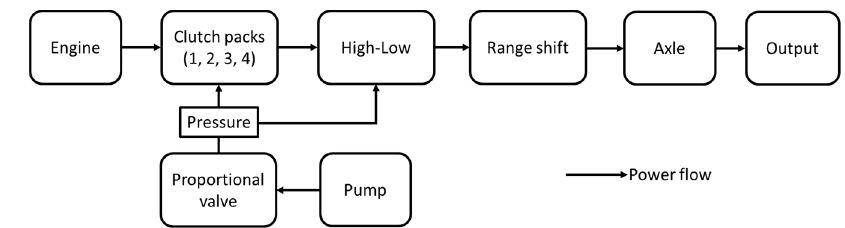
Figure 2. The block diagram of the PST configuration.